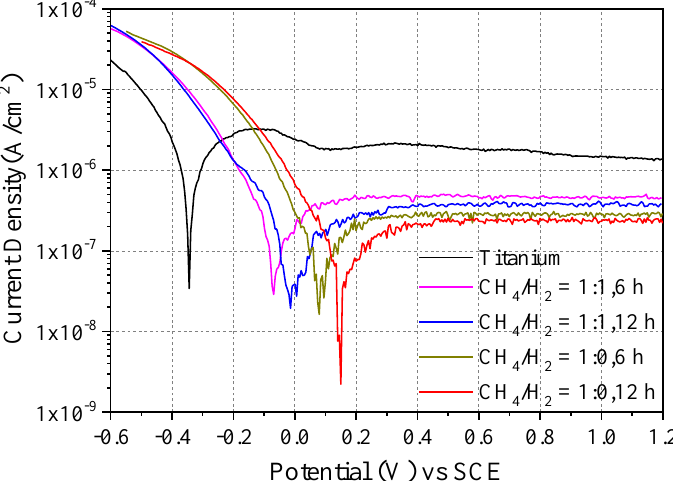
Figure 12. Potentiodynamic behaviors of uncoated titanium and various DLC films coated on tita- nium in 0.5 mol/L H 2 SO 4 at 90